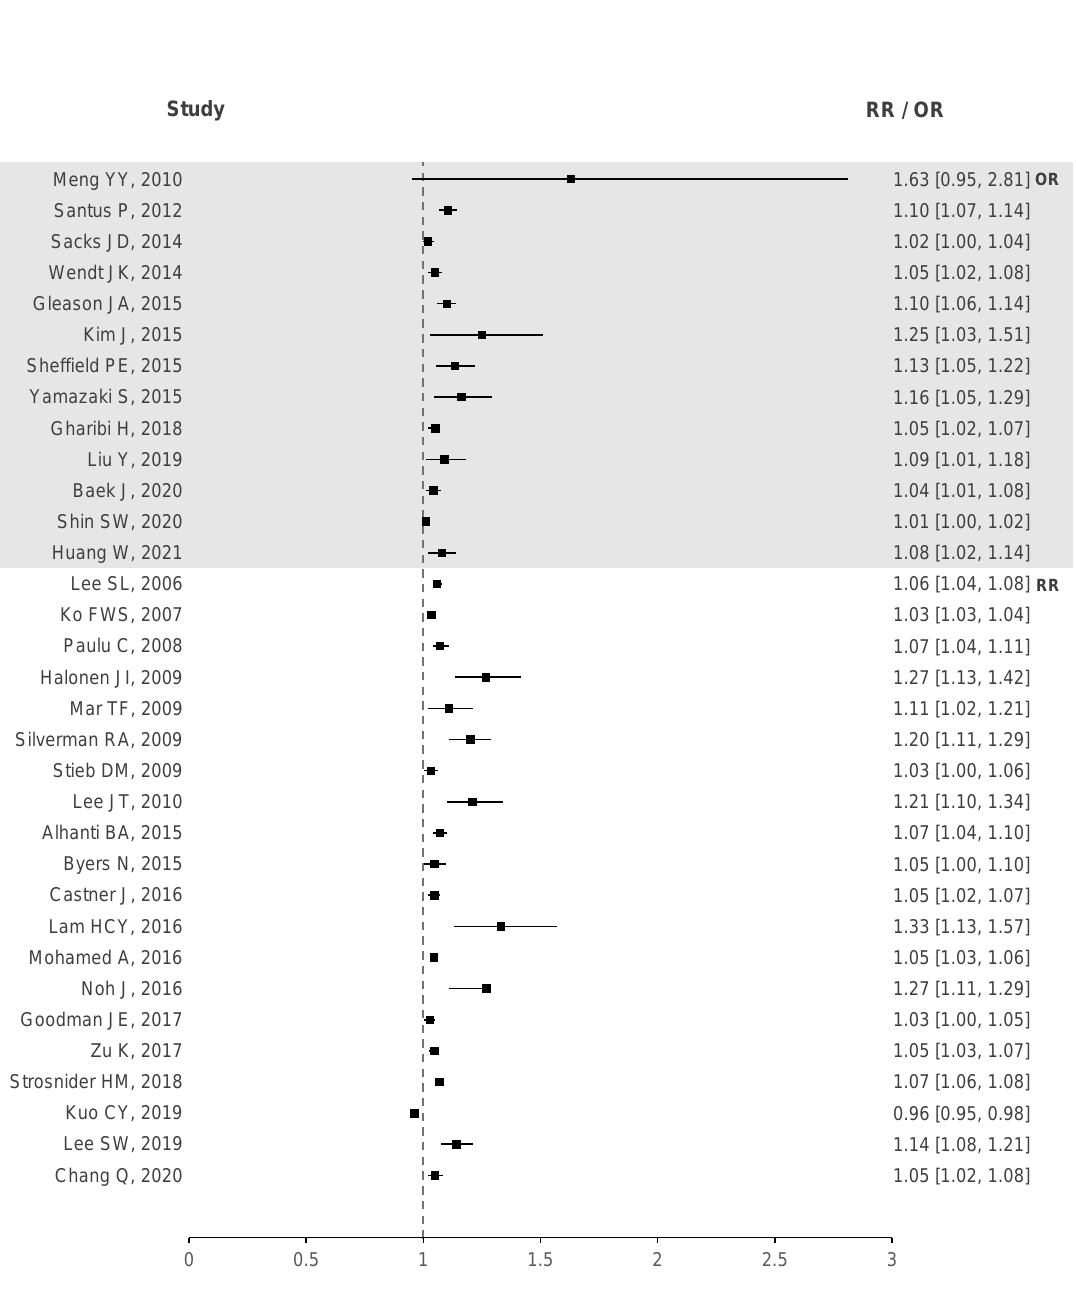
Figure 4. Asthma forest plots of O 3 increased risk